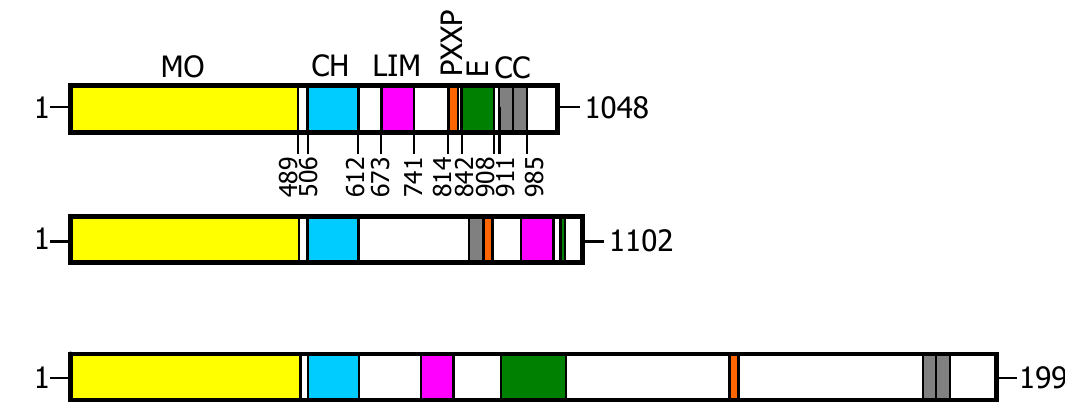
Figure 1. Domain organization of Molecule Interacting with CasL (MICAL) forms. The boundaries of the domains are referred to the mouse forms. From top to bottom: MICAL1, MICAL2 and MICAL3. See text for